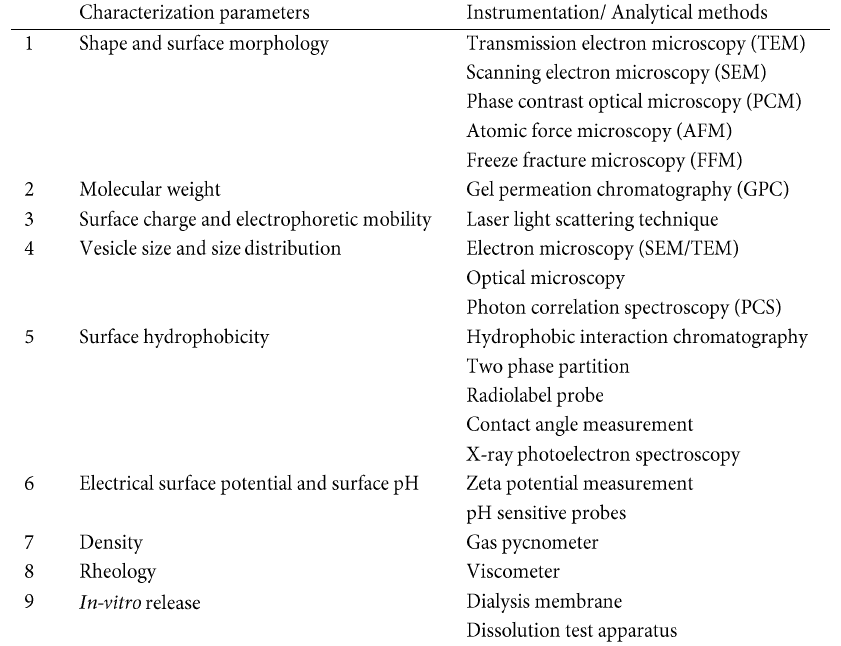
Table 1: Characteristics of